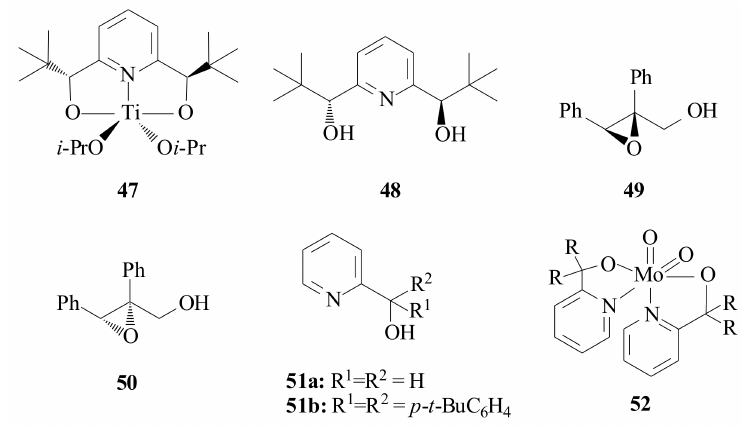
Figure 9. Ligands, complexes and epoxide